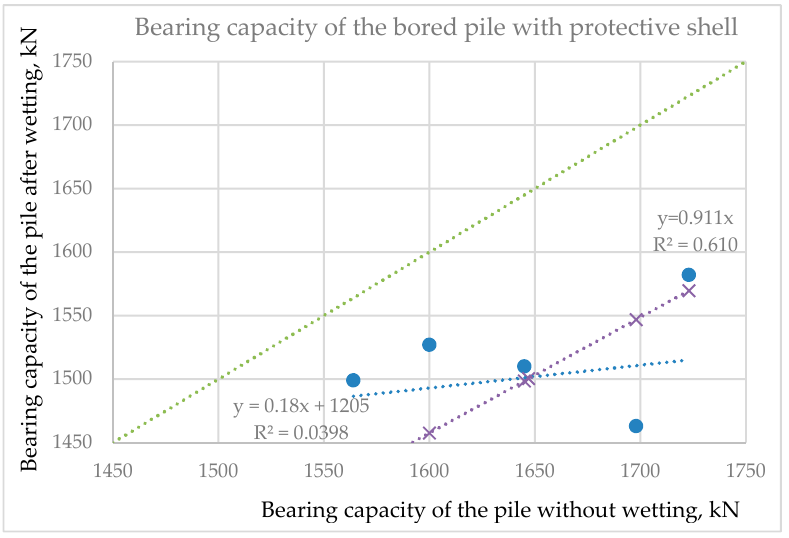
Figure 11. Comparative diagram of the bearing capacity of piles with protective shell, after and without wetting.